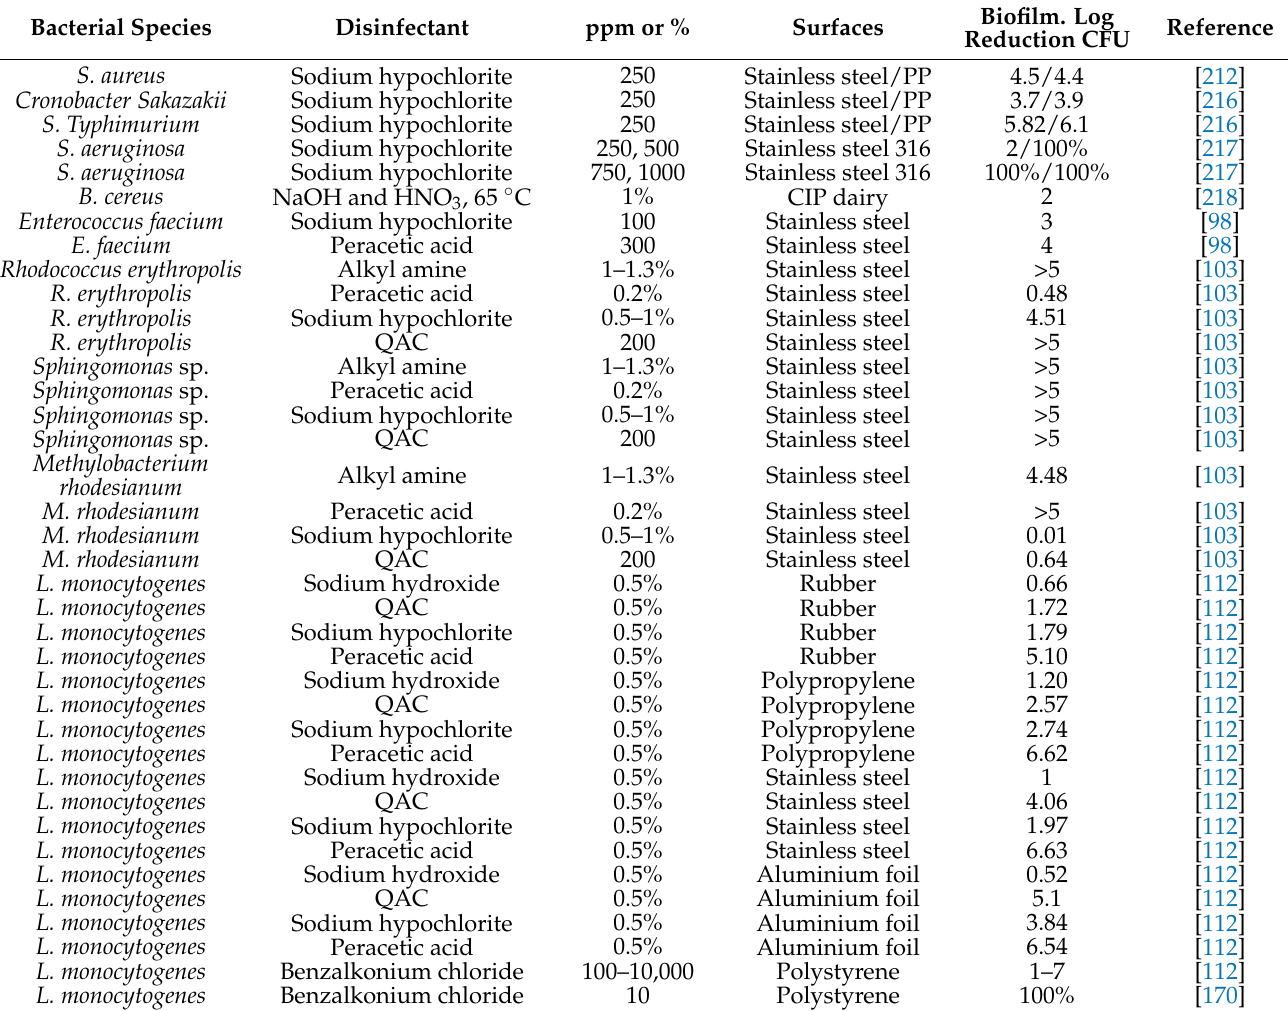
Biofilm. Log Reduction CFU